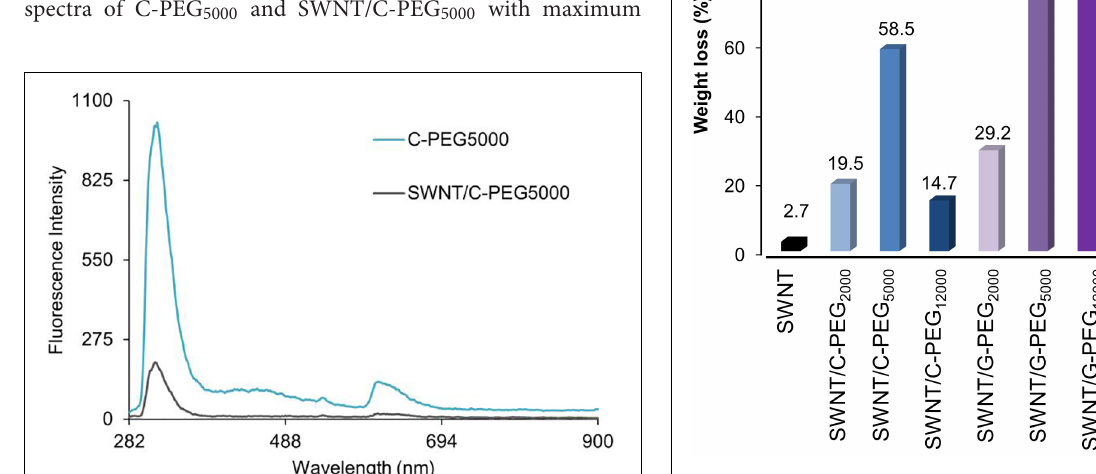
FIGURE 8 | Fluorescence spectra of C-PEG 5000 and SWNT/C-PEG 5000 .